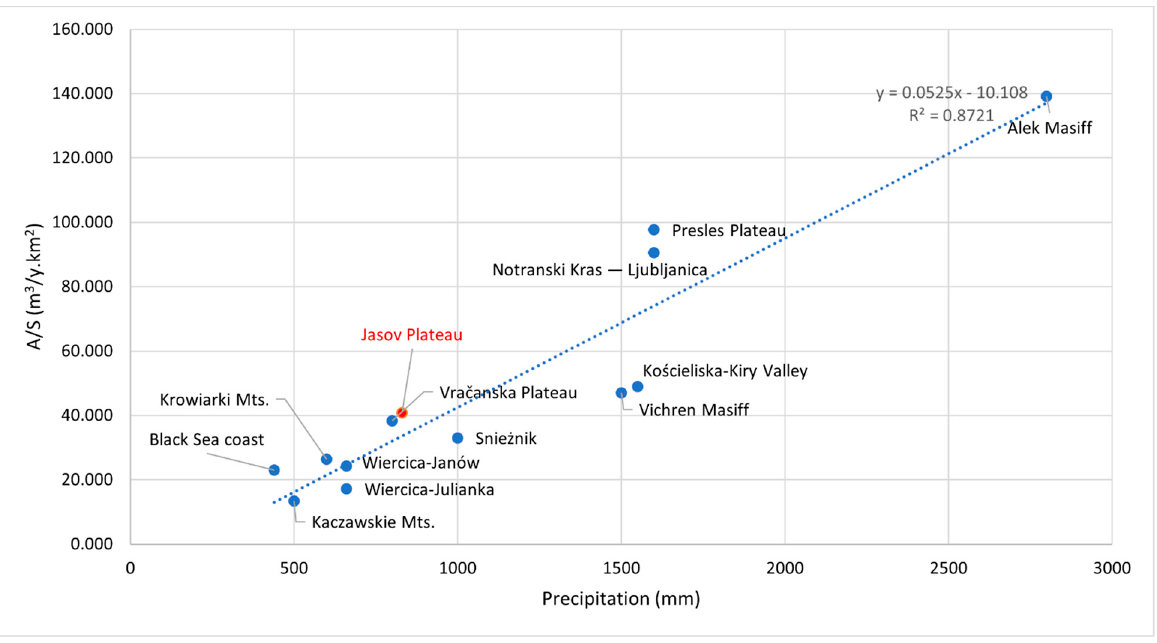
Figure 10. Relationship of precipitation and A/S (ionic runoff/area). Study areas of [5,23] and Slovak Karst, localities described in Table 2.